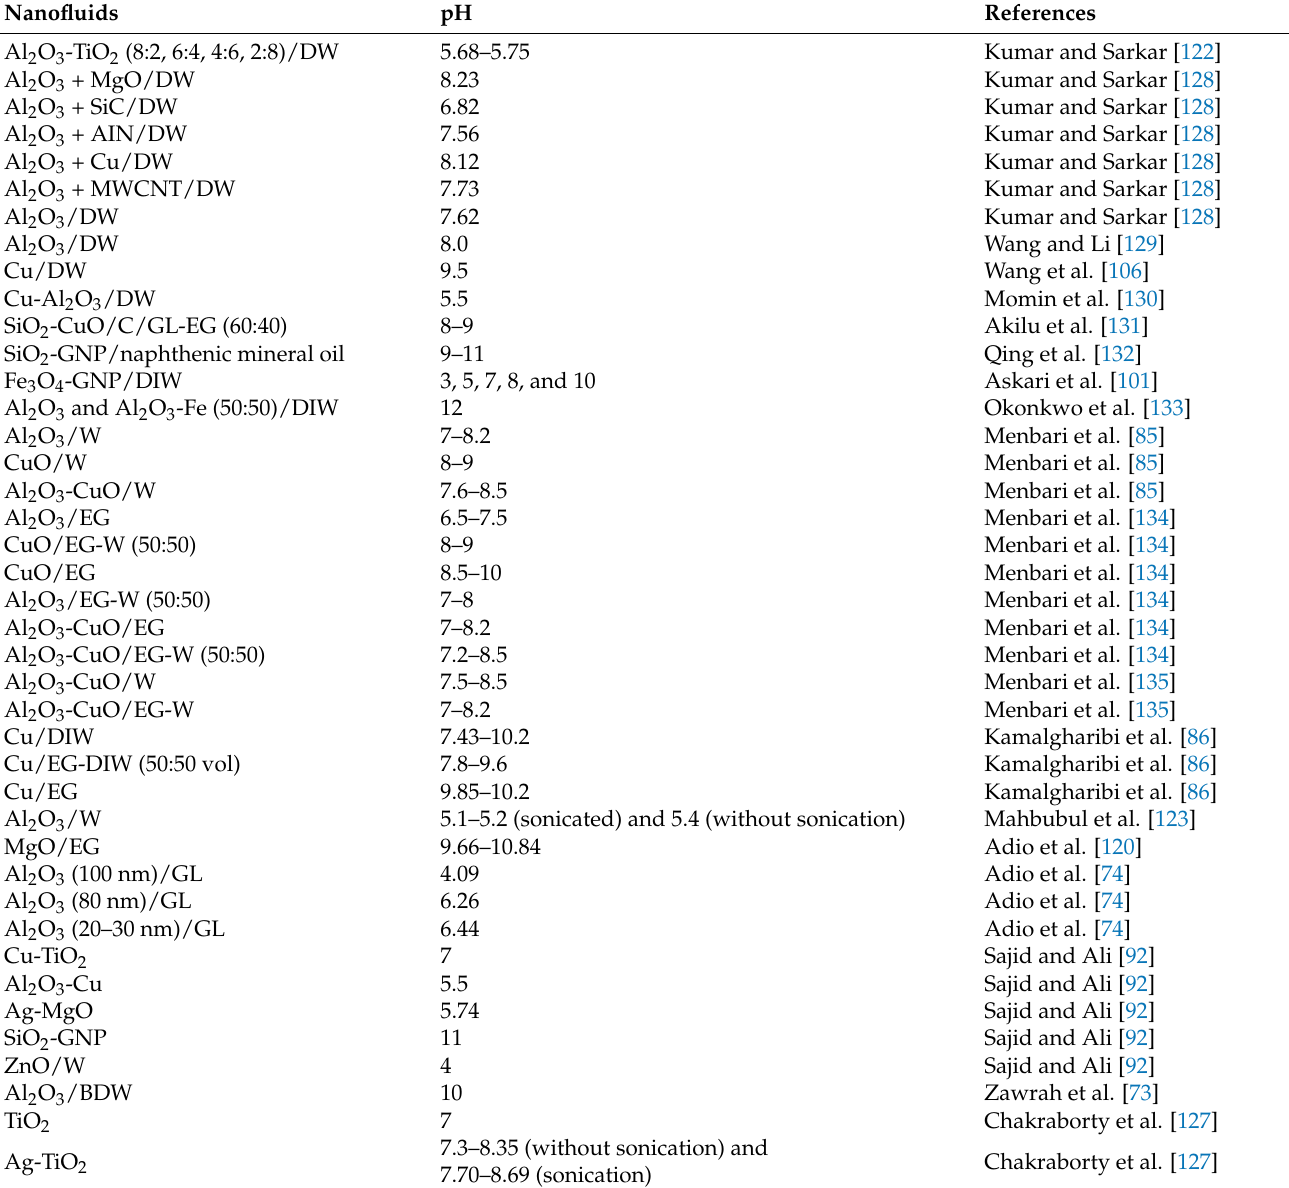
Table 3. pH of mono and hybrid